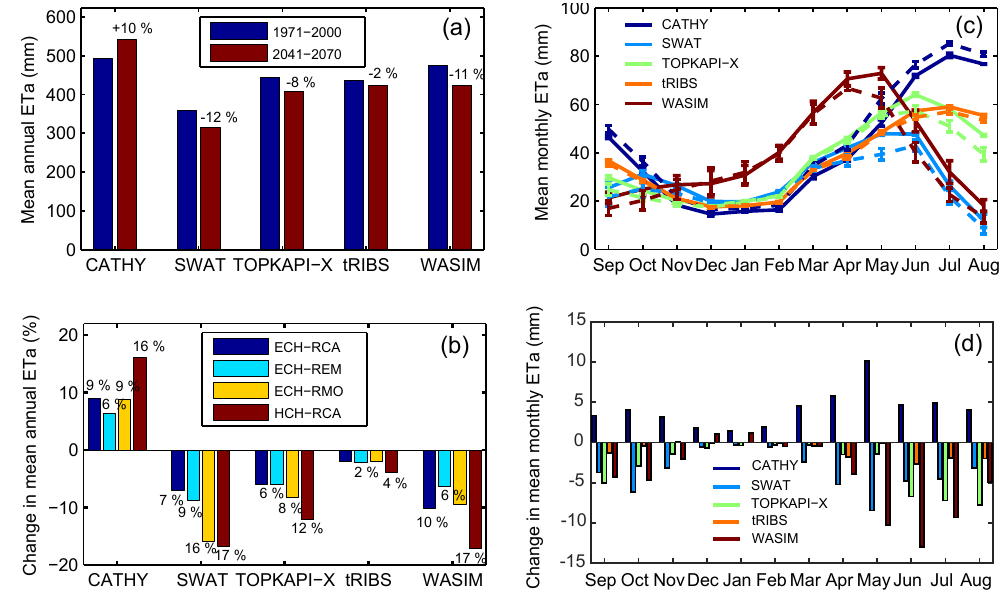
Figure 9. As Fig. 6, but for actual evapotranspiration (ET a ) simulated by each hydrologic model forced by the four selected climate models for the reference (REF, 1971–2000) and future (FUT, 2041–2070)